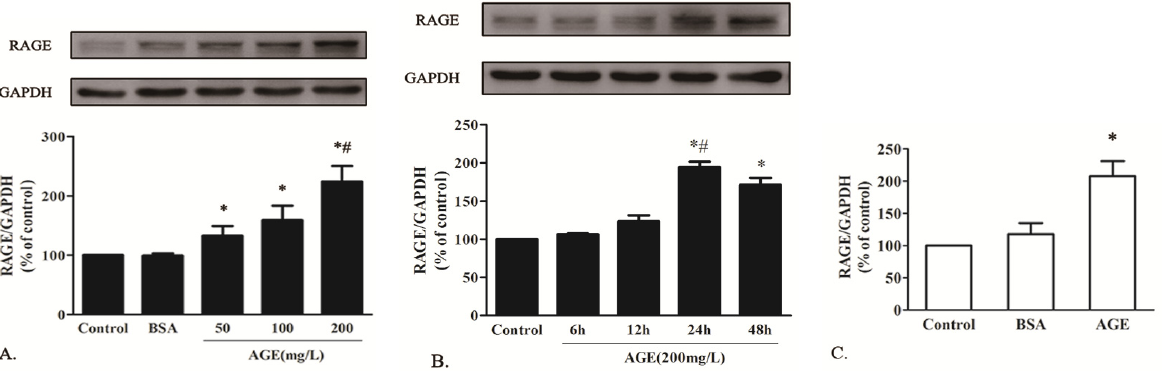
Figure 3. The effect of AGE on RAGE expression in cardiomyocytes. ( A ) AGE upregulated the RAGE protein expression in a dose-dependent manner and peaked at 200 mg/L; ( B ) AGE increased the RAGE protein expression in a time-dependent manner and peaked at 24 h; ( C ) RAGE mRNA level was upregulated by AGE (200 mg/L) treatment for 24 h. * p < 0.05 vs. control, BSA (200 mg/L); # p < 0.05 vs. AGE (50 mg/L, 100 mg/L) or AGE (6h, 12h, 48 h); Data are mean ±